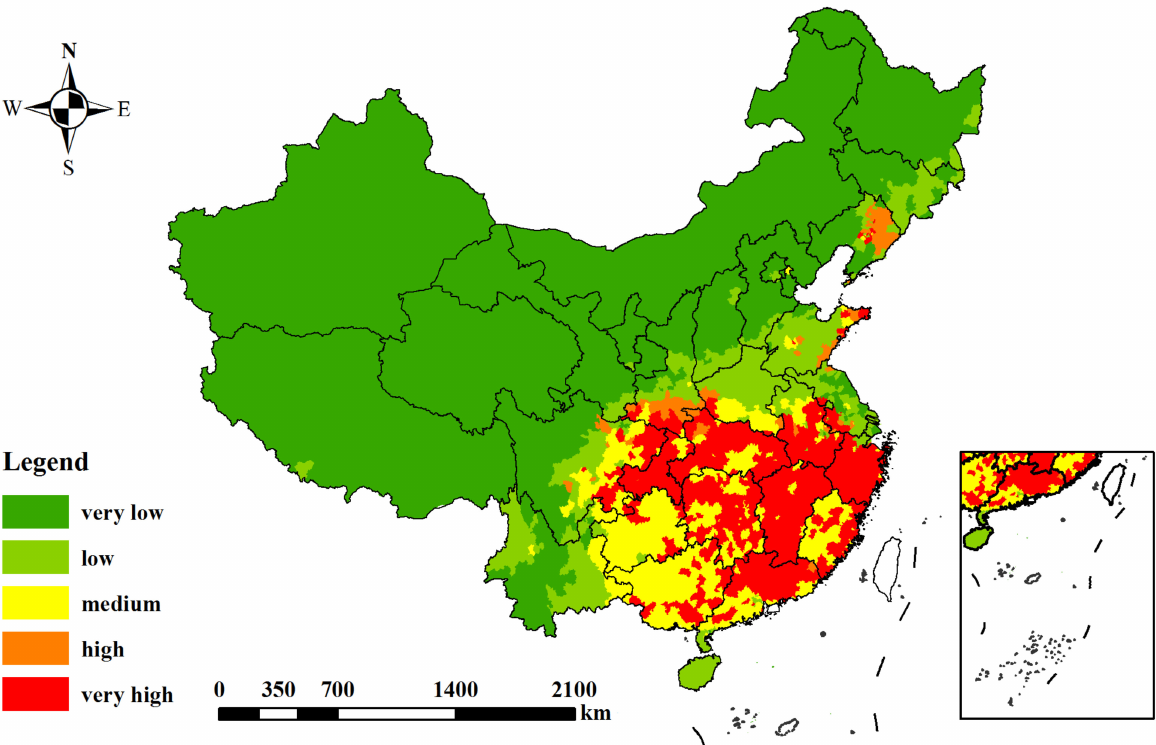
Figure 6. Risk assessment of PWD-damaged forests in